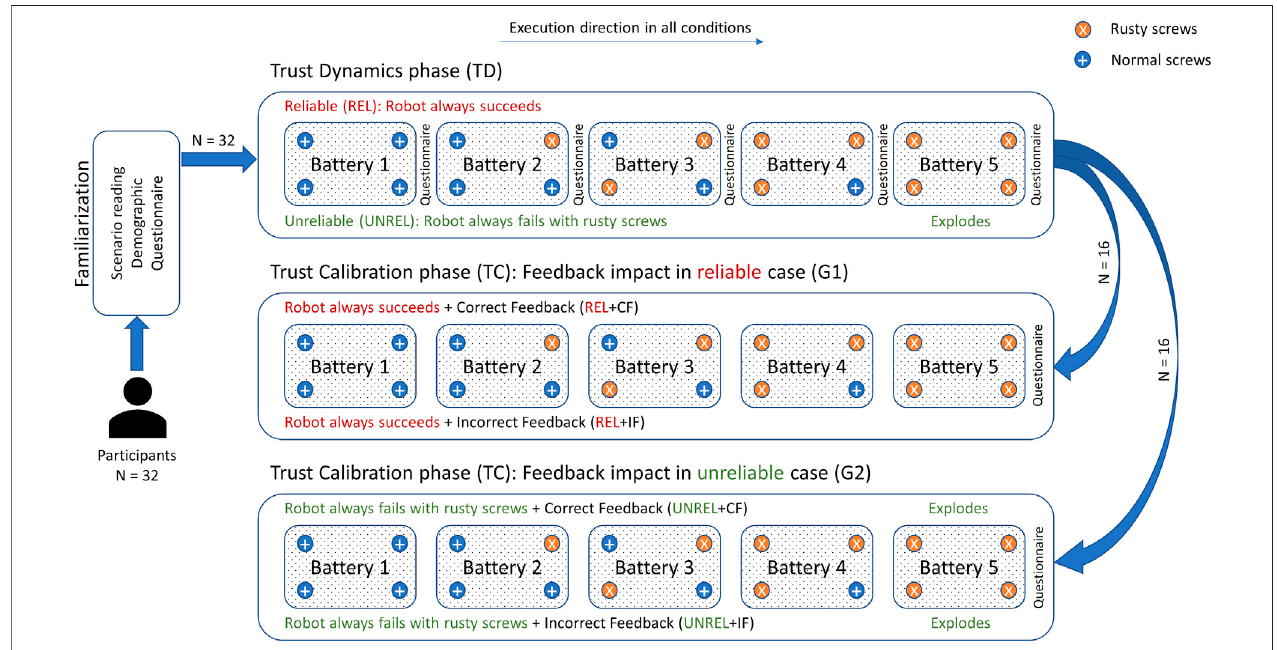
FIGURE 3 | Experimental procedure. Participants start with TD phase and fi ll a questionnaire after each battery. They proceed with TC phase depending on the group, where only one questionnaire is administered. Batteries should be handled in their order. In TD phase, trust dynamics is studied. In the TC phase, the effect of verbal feedback on human trust is studied with different reliability